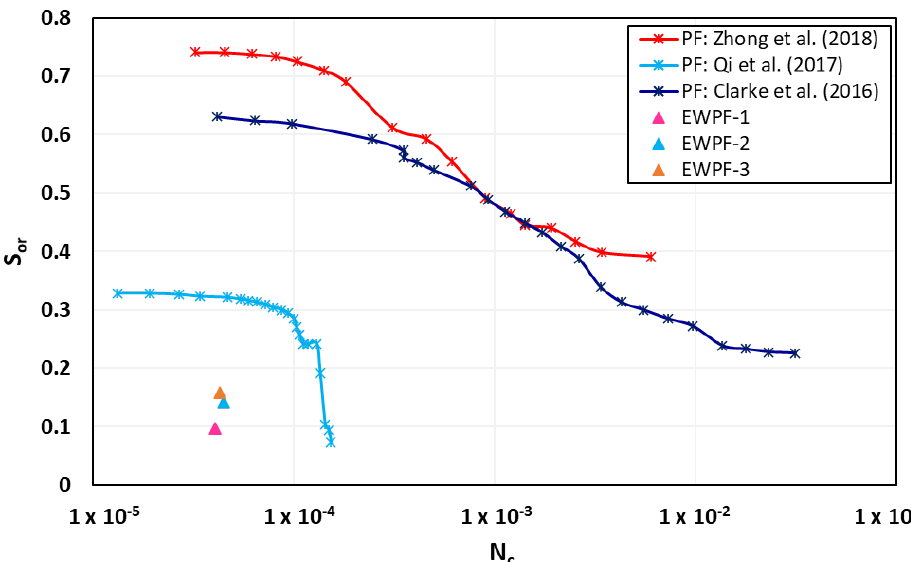
Figure 4. Comparison of capillary desaturation tendency of hybrid EWPF with conventional PF.